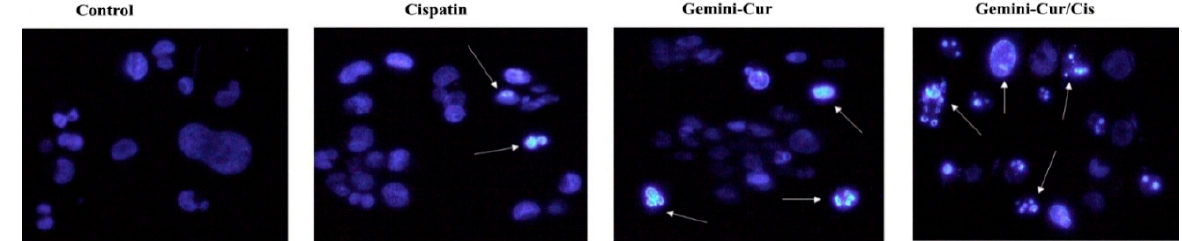
Figure 3. Morphological observation of apoptosis in Gemini-Cur and cisplatin treated cells by Hoechst staining in 48 h. Control shows a uniform exposure of live cells to stain. The color intensity and the number of cells indicating apoptotic features are significantly increased in treated groups. Arrows indicate apoptotic cells with cell shrinkage, nuclear fragmentation and DNA condensation. Magnification: 200×.